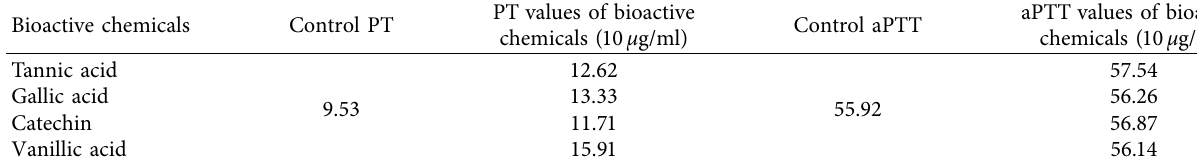
Here, the values are expressed in time (sec.).